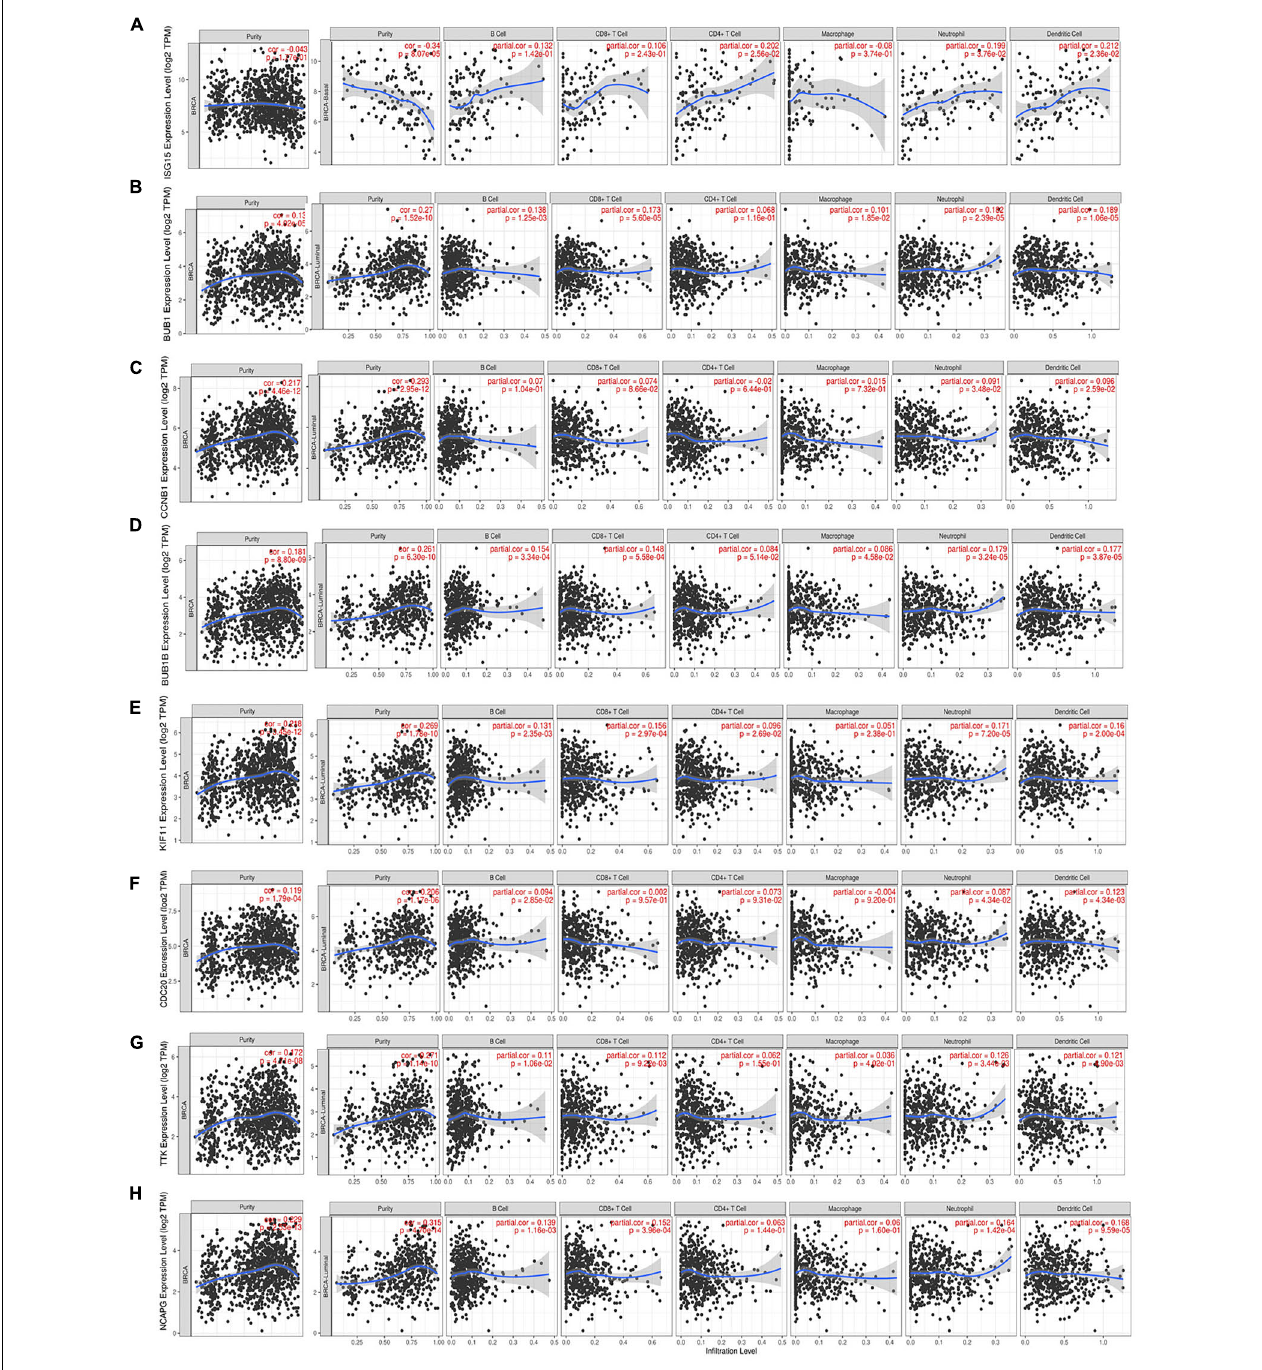
FIGURE 7 | Correlation of each hub gene’s expression with immune infiltration levels in BC. Complete correlation analysis results for BC subtypes are given in Supplementary Figure 5 . Correlation of ISG15 (A) , BUB1 (B) , CCNB1 (C) , BUB1B (D) , KIF11 (E) , CDC20 (F) , TTK (G) , and NCAPG (H) expression with TICs.